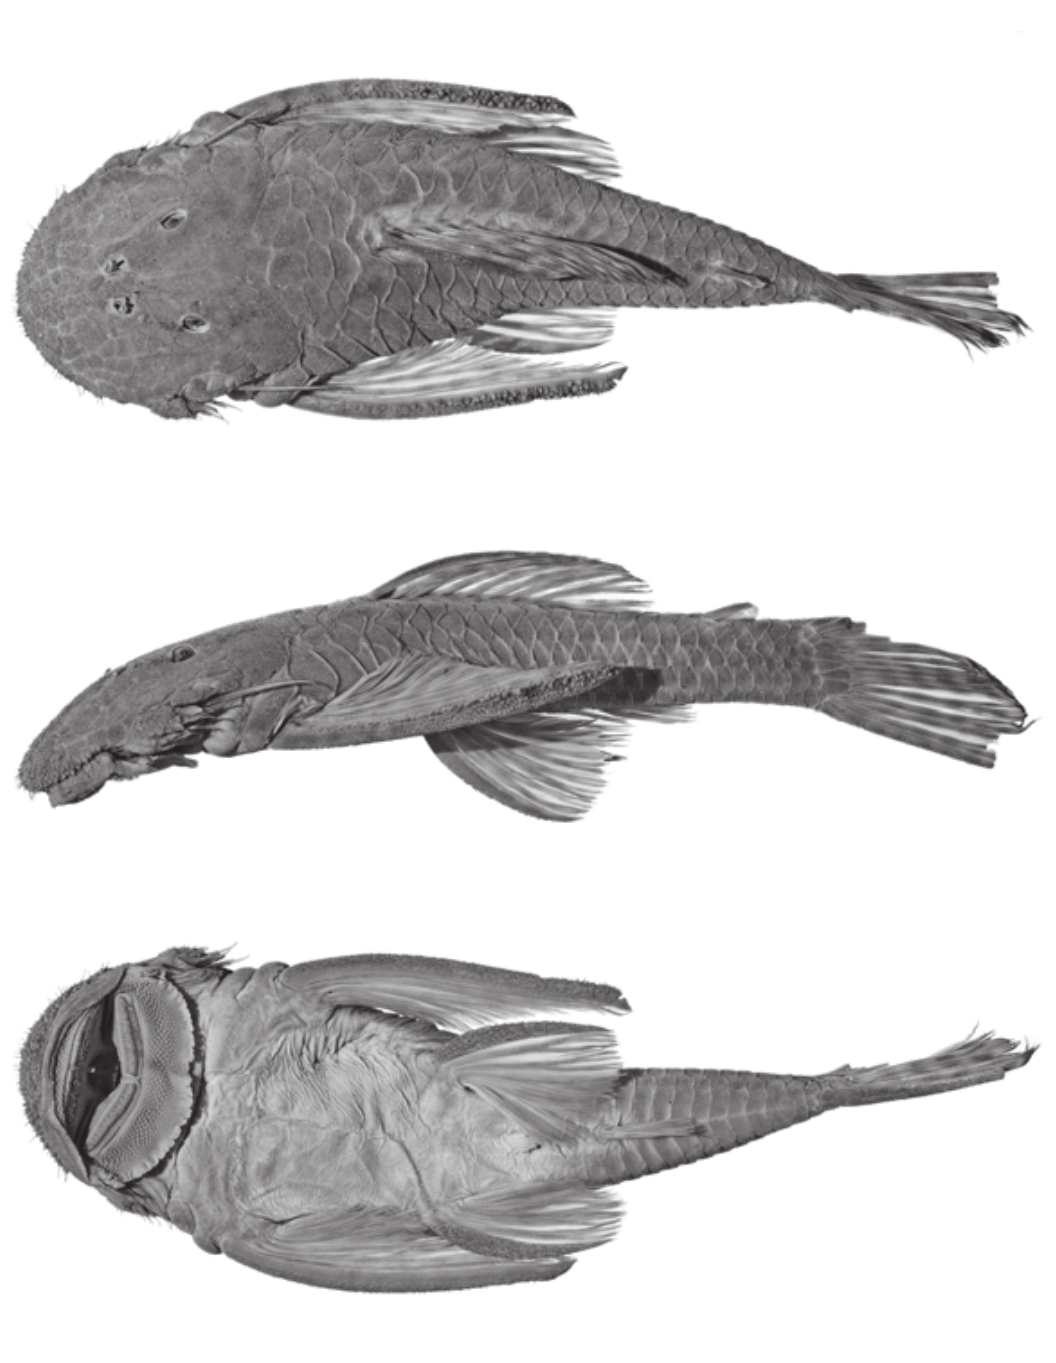
Fig. 3. Dolichancistrus carnegiei , CAS 56749, 126.4 mm SL. Colombia, Departamento de Boyacá, río Baipé: dorsal, lateral and ventral